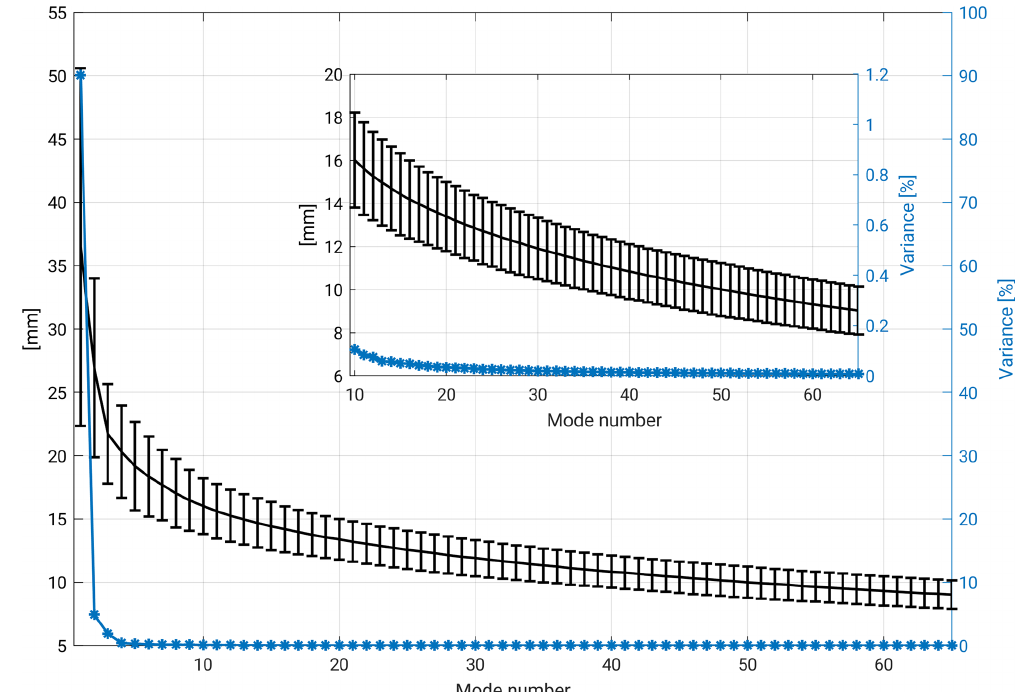
Figure 5. Percentage of variance (blue) and daily averaged root-mean-square error (black) including standard deviation of FESOM original data and reconstructed signal for 65 modes of principal component synthesis. For better overview, modes 10–65 are zoomed in.